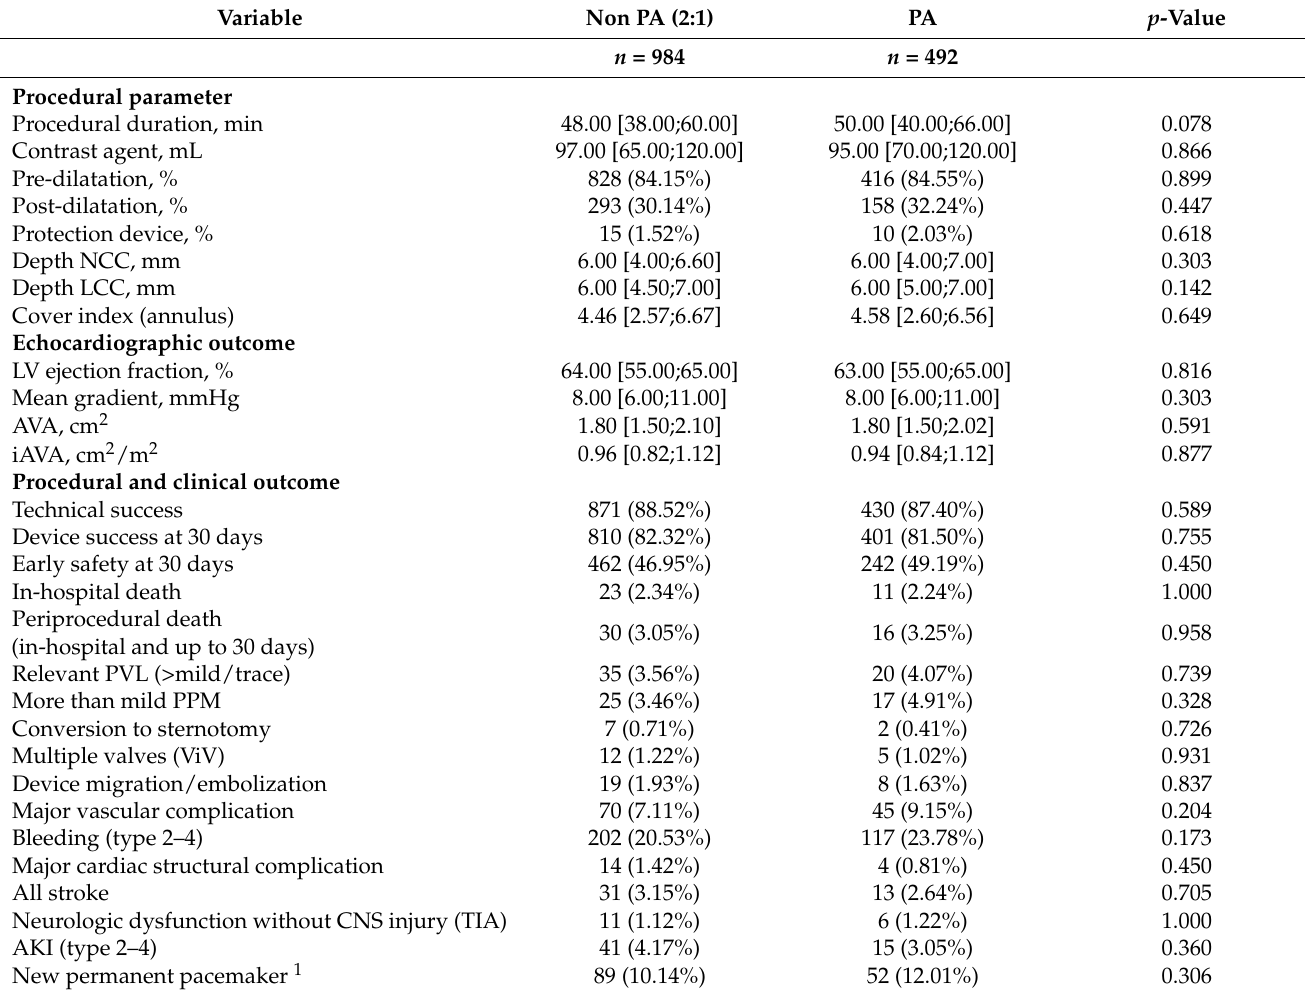
Table 3. Procedural outcomes and complications (matched